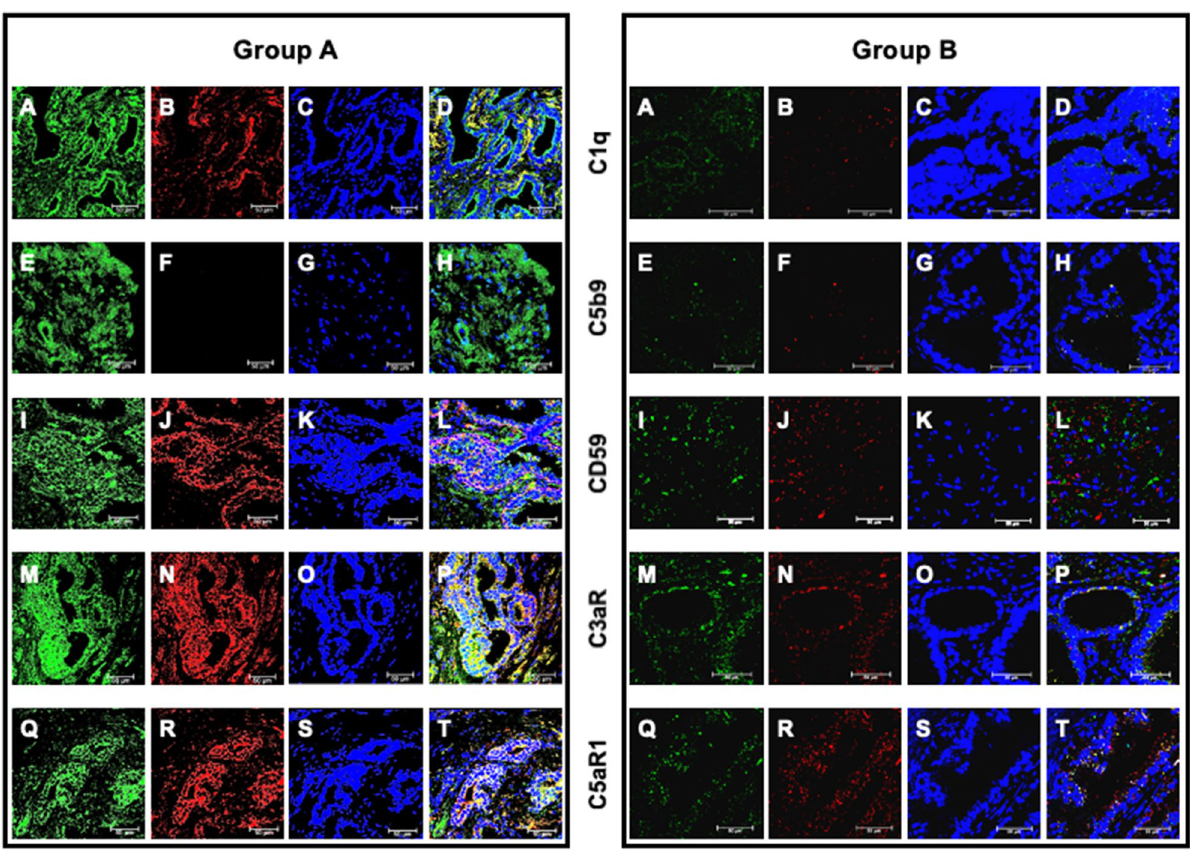
Figure 6. C1q and C5b-9 deposition and CD59, C3a and C5a receptor expression and their co-localization with PTX3 in second biopsy of patients who developed prostate cancer (group A) or not (group B). PTX3 ( A , E , I , M , Q ), C1q ( B ), C5b-9 ( F ), CD59 ( J ), C3a ( N ) and C5a receptor ( R ) proteins were investigated by double- label immunofluorescence and confocal microscopy as detailed in Materials and Methods. TO-PRO-3 was employed to counterstain nuclei (blue; C , G , K , O , S ). Merged images (yellow; D , H , L , P , T ) demonstrated the co-localization (green) of C1q ( D ), CD59 ( L ), C3a ( P ) and C5aR1 ( T ) with PTX3, whereas no co-localization was evident for C5b-9 ( H ). Bar length = 50